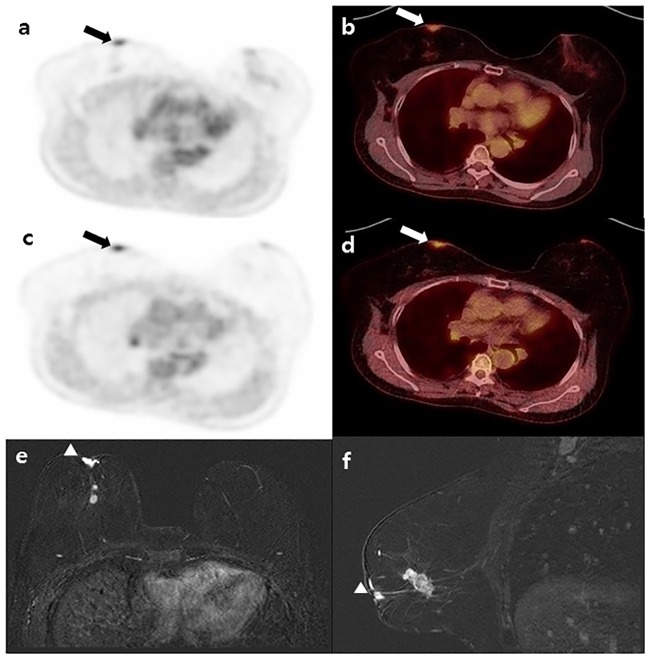
A 51-year-old patient with invasive ductal carcinoma (IDC) in the right breast: (a, b) Early phase 18F-FDG PET and fusion PET/CT; (c, d) Delayed phase PET and fusion PET/CT depict focal FDG uptake in the NAC of the right breast (arrow; ROI of NAC showing green color), NAC-SUVRearly = 2.35; NAC-SUVRdelay = 2.95; (e) Contrast-enhanced MRI with axial view and (f) MRI with sagittal view; MRI shows unilateral NAC enhancement and asymmetric thickening of the NAC (arrowhead).This patient underwent mastectomy, and NAC involvement was pathologically confirmed.